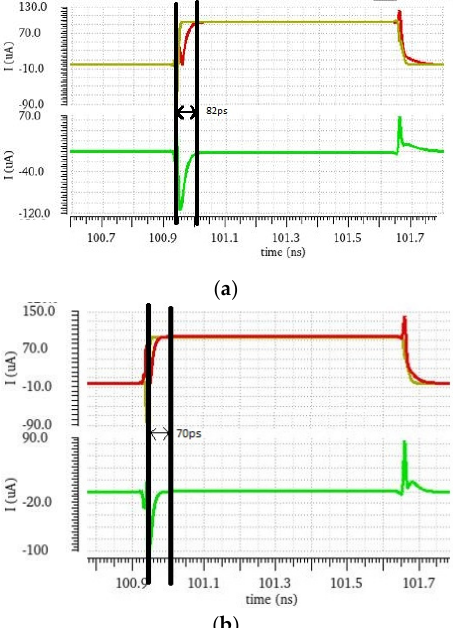
Figure 9. Comparison of optimized charge pumps: ( a ) after manually optimization; ( b ) after prediction-based optimization.